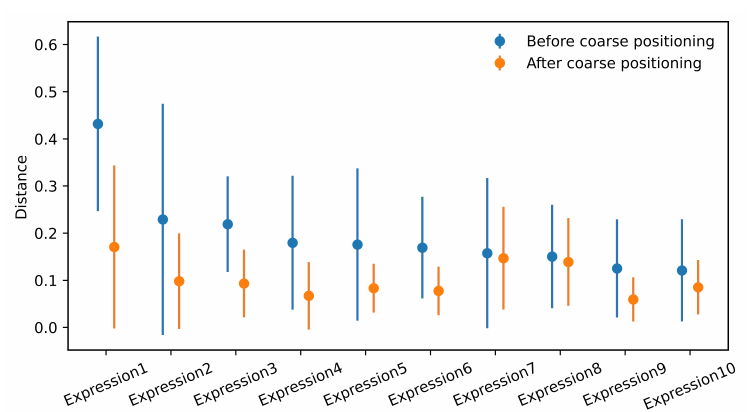
Figure 8. The distances between point pairs of different expressions. The values represent the proportion relative to the width of eye contour.